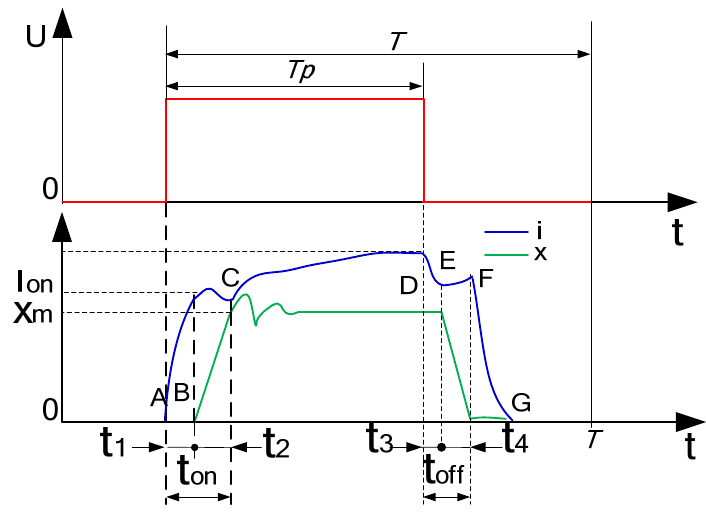
Figure 3. Signal–displacement relation diagram of digital valve.